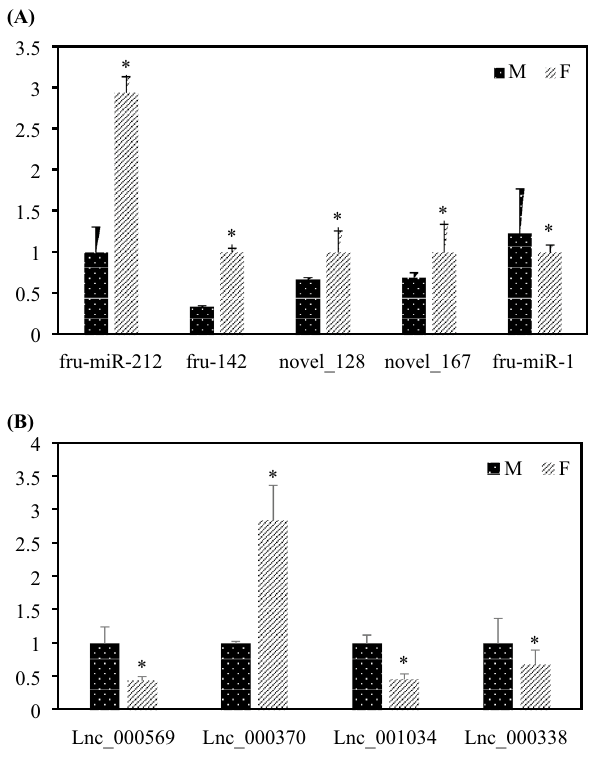
Figure 7. qPCR validation of the differentially expressed miRNAs ( A ) and lncRNAs ( B ) identified using Solexa sequencing. Each value represents the mean ± SEM of three measurements; * P < 0.05 between the XX and XY gonads, Student t